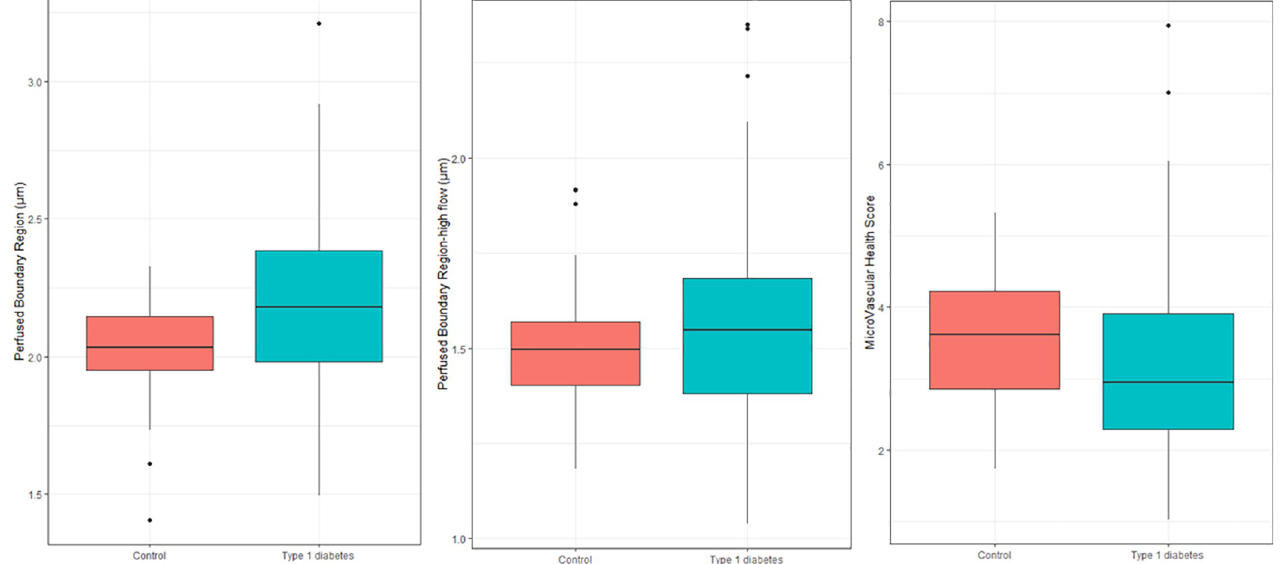
Fig 2. Glycocalyx measurements within the group of healthy controls and type 1 diabetes. Perfused Boundary Region (p < 0.001), Perfused Boundary Region-high flow (p = 0.13) and MicroVascular Health Score (p = 0.02). P-values are for the unadjusted analyses.